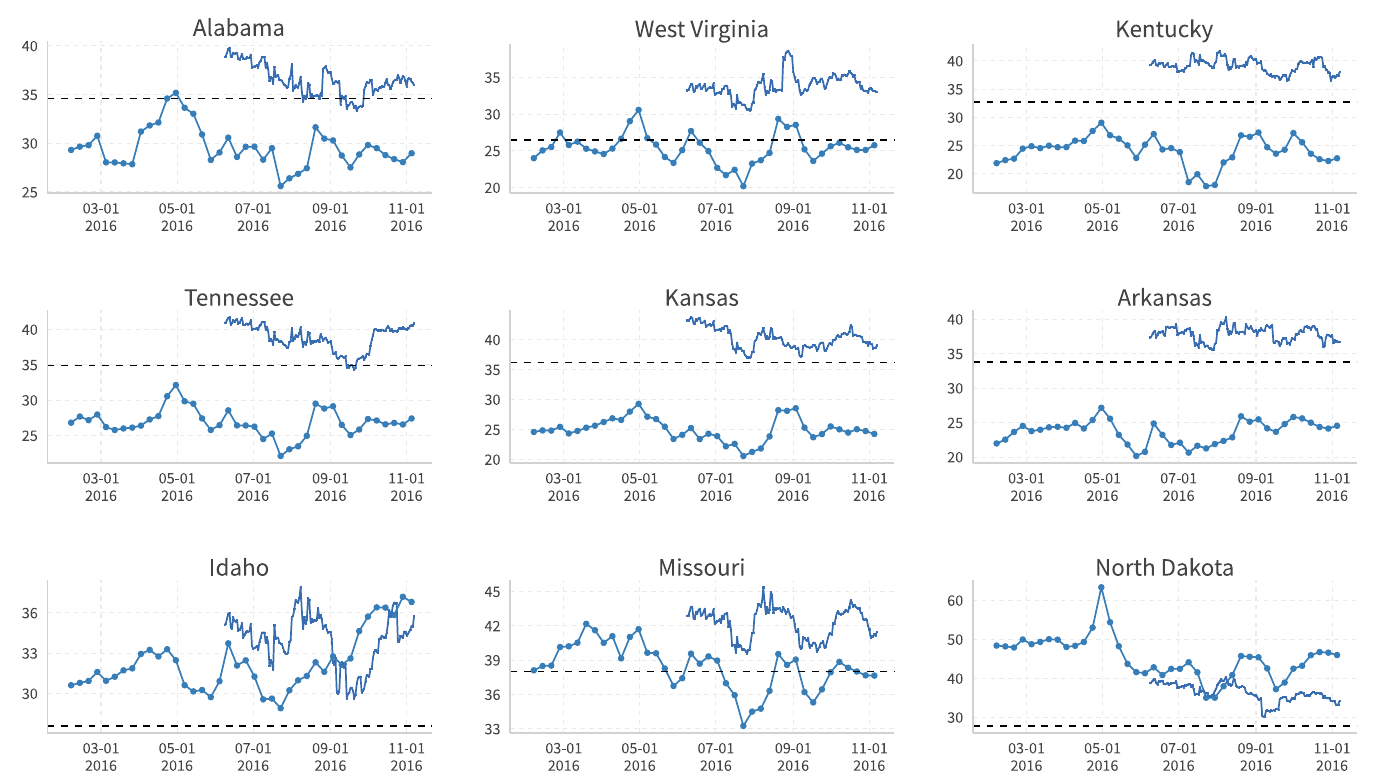
Fig 19. Clinton’s Facebook support rate (dotted line), 538 polling average (undotted line), and 2016 actual vote share (dashed line) in selected red states. Facebook support rate: Share of user’s ideology closer to Clinton. 538 Polling Average: “Nowcast” from [27]. Dickey-Fuller and Phillips-Perron cointegration tests after controlling for candidate-state fixed effects are implemented, where the null hypothesis of no cointegration between these two series is rejected.